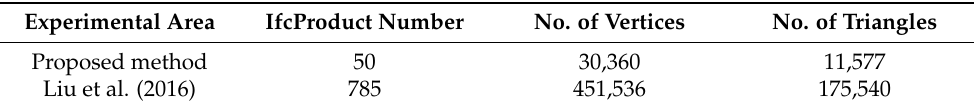
Table 5. Statistical information for interior building entities when the outdoors is not visible.